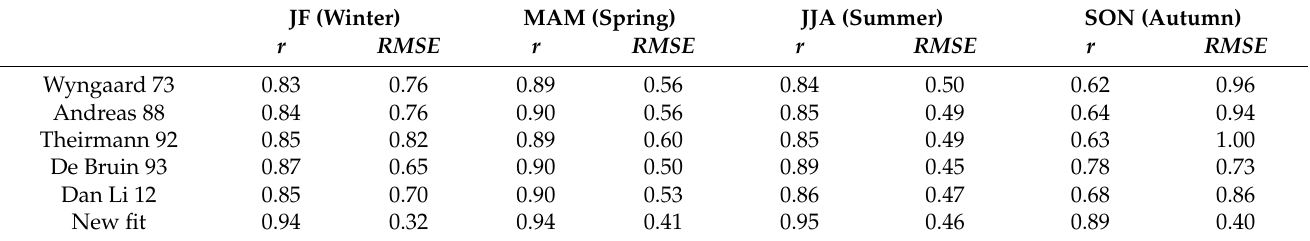
Table 3. Correlation coefficient ( r ) and the root mean square error ( RMSE ) between measured and (cid:0) (cid:1) C 2 n estimated log results of different models in four seasons. 10 JF (Winter) MAM (Spring) JJA (Summer) SON